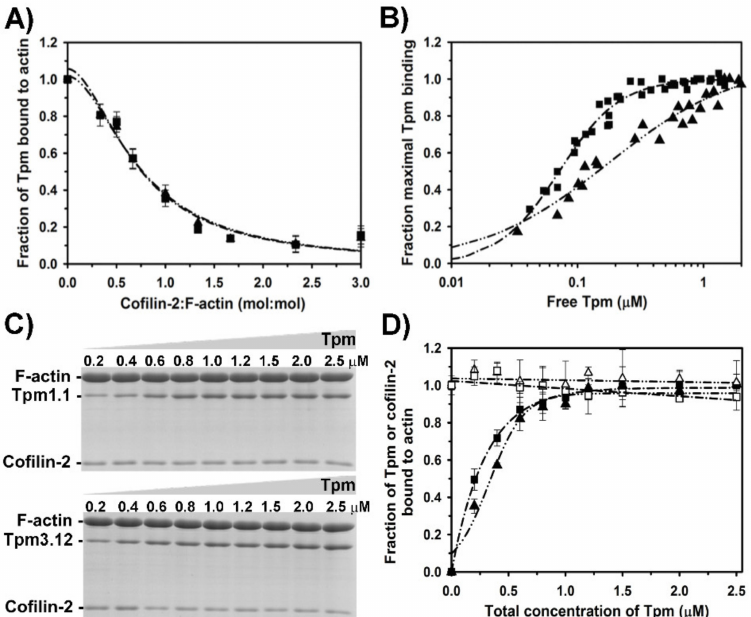
Figure 3. Interactions of Tpm1.1 and Tpm3.12 with F-actin in the presence of cofilin-2. ( A ) Dissociation of Tpm1.1 (triangles, dash-dot-dot line), Tpm3.12 (squares, dash-dot line) from F-actin by increasing concentrations of cofilin-2. The points were averaged from three independent experiments ± SE. Protein concentrations: 3 µ M F-actin, 1.0 µ M Tpm1.1 or Tpm3.12, 0–10 µ M cofilin-2. ( B ) Binding of Tpm1.1 (triangles, dash-dot-dot line), Tpm3.12 (squares, dash-dotted line) to 3 µ M F-actin in the presence of 1 µ M cofilin-2. The points were collected from three independent experiments. ( C ) Electrophoretic separation of the proteins collected in pellets after ultracentrifugation of 3 µ M F-actin with 0–2.5 µ M Tpm1.1 (upper panel) or Tpm3.12 (lower panel) in the presence of 1 µ M cofilin-2. ( D ) Densitometric analysis of the protein bands separated on gels illustrated in ( C ). Fraction of cofilin-2 bound to F-actin in the presence of either Tpm1.1 (open triangles, dash-dot-dot line) or Tpm3.12 (open squares, dash-dotted line). Fractional saturation of F-actin with Tpm1.1 (triangles, dash-dot-dot line) or Tpm3.12 (squares, dash-dotted line) in the presence of 1 µ M cofilin-2. Other conditions: 5.0 mM Tris-HCl, pH 7.5, 100 mM NaCl, 2.0 mM MgCl 2 , 1 mM